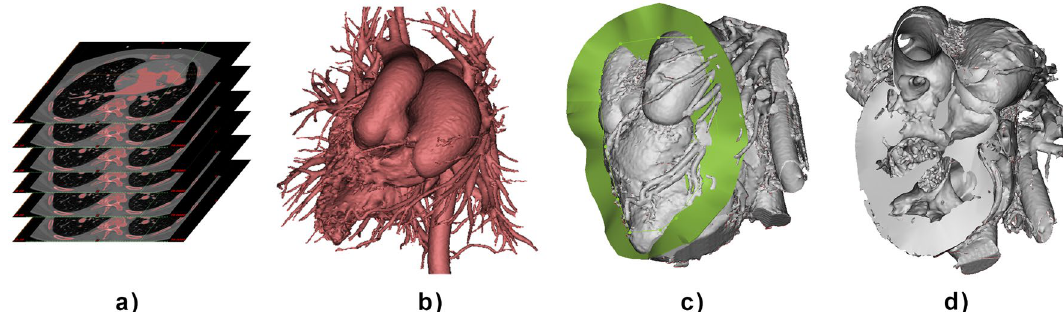
Figure 1. Process of segmentation and modeling. ( a ) Segmentation of CT images. ( b ) Blood pool model. ( c ) Cutting of the myocardial model. ( d ) Myocardial model cut with a flexible